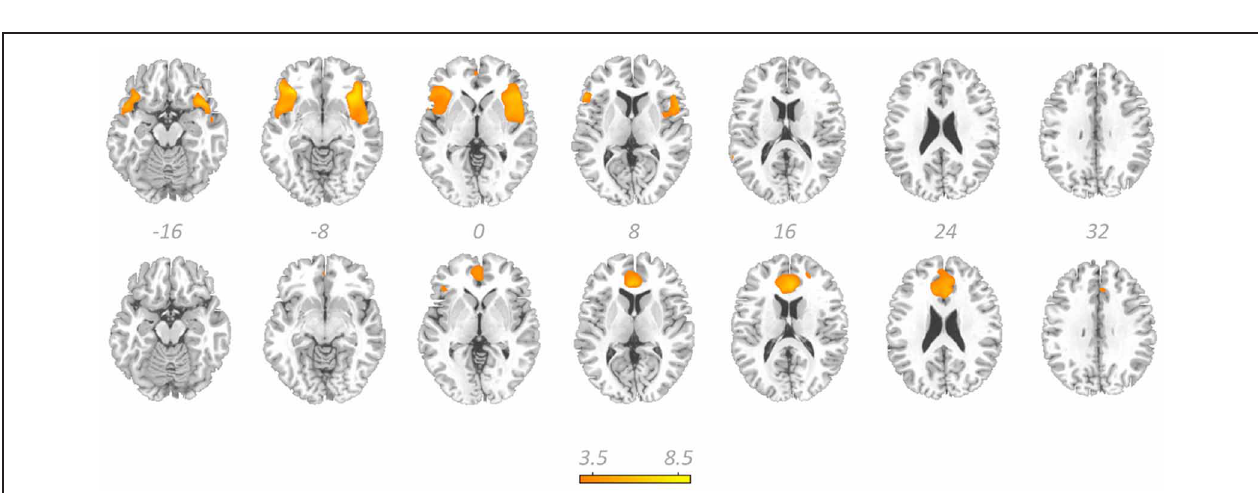
Colorbar denotes T -scores from one sample T -tests and relates to both components. These images are thresholded at uncorrected P -threshold of